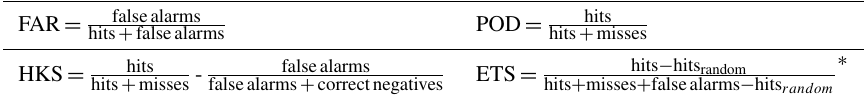
Table 5. Mathematical definition of the statistics scores: probability of detection (POD), false-alarm rate (FAR), equitable threat score (ETS) and Hanssen–Kuipers score or true skill statistic (HKS).